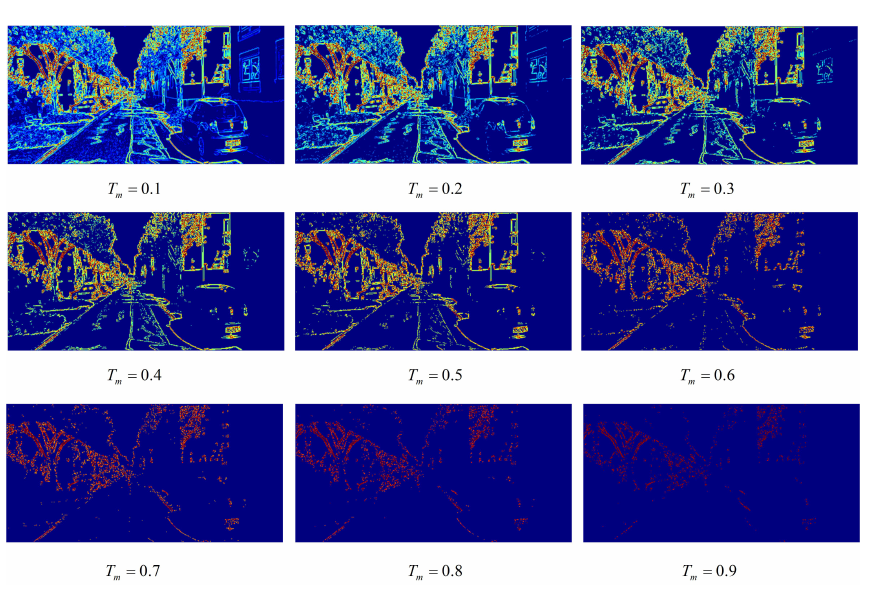
Figure 8. Edge attentive heat map with different T m